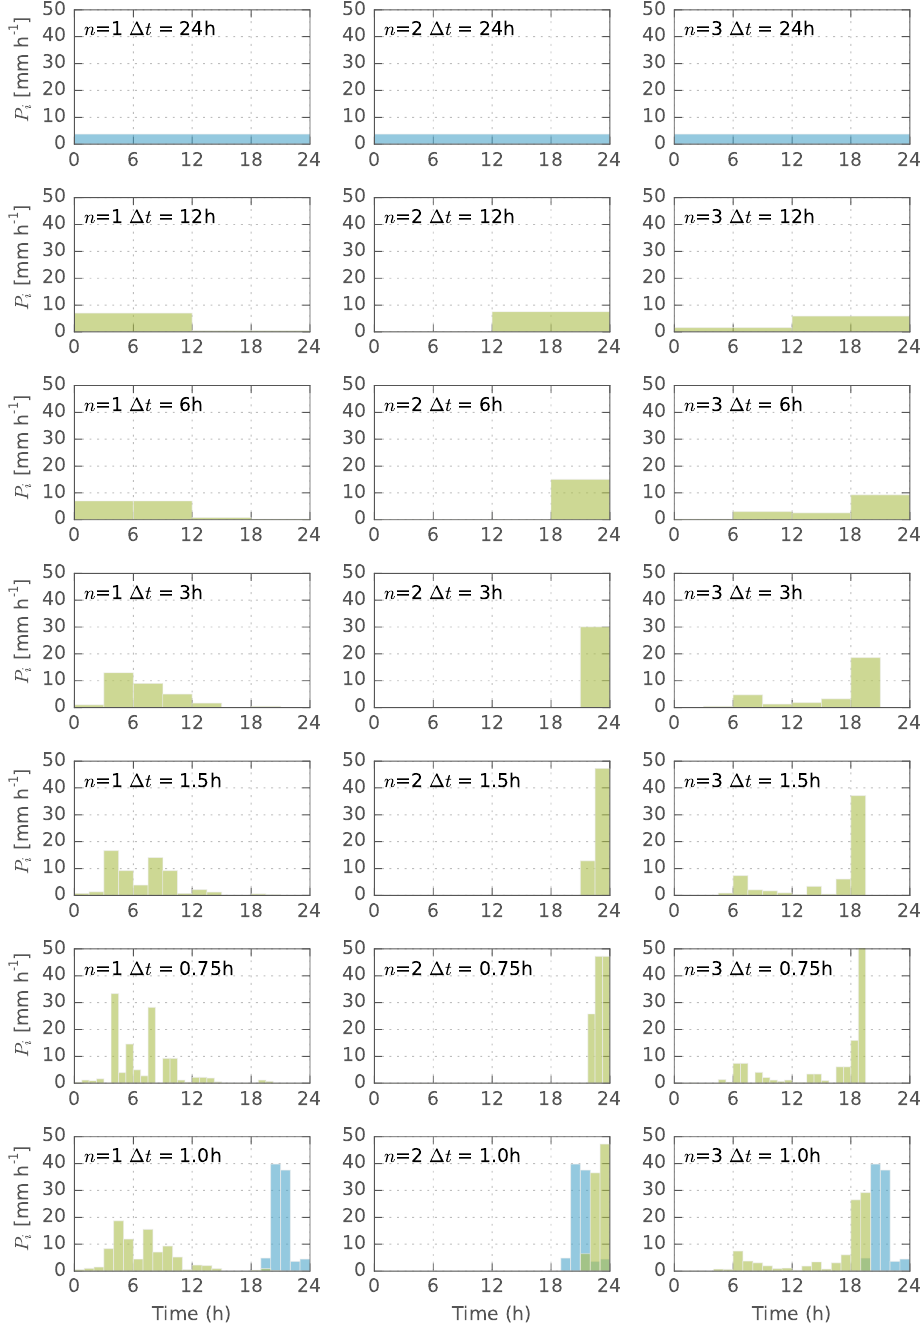
Figure 7. Example for precipitation disaggregation using the cascade model: 1h rainfall observed at Rio de Janeiro – São Cristovão on 5 December 2010 (blue). Based on statistical evaluations of long-term hourly precipitation series and their aggregation to coarser temporal resolutions, all relevant steps of the cascade disaggregation applied to daily totals are presented (green). The time series of each cascade level are shown for three realisations of the model n = 1 (left), n = 2 (centre), and n = 3